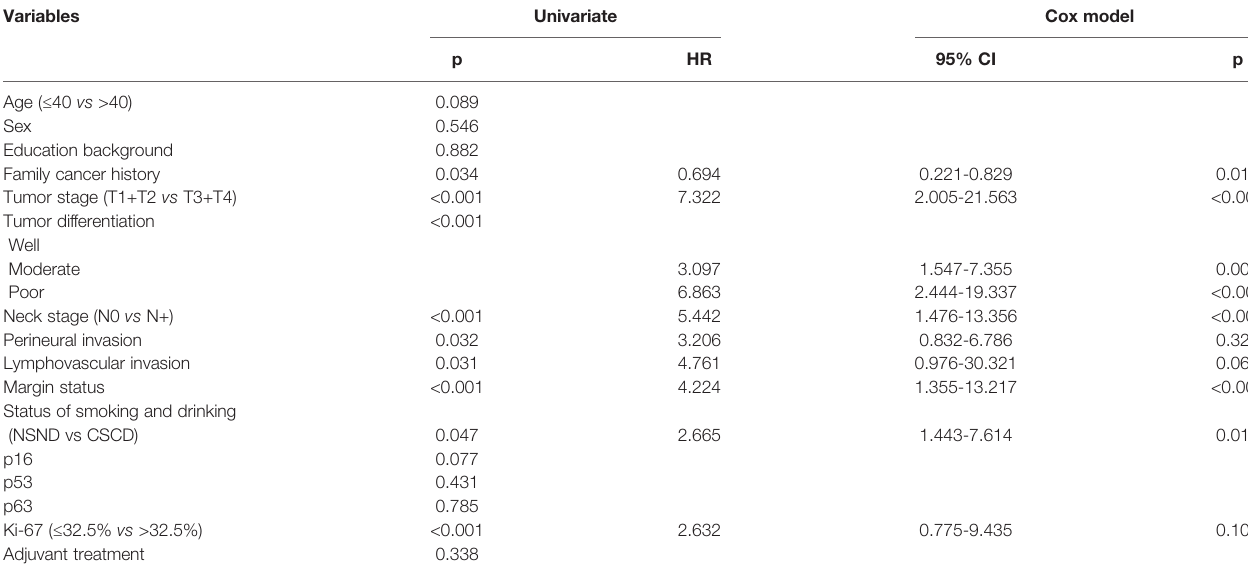
TABLE 3 | Univariate analysis and Cox model analysis of risk factors for cancer-caused death in oral squamous cell carcinoma.